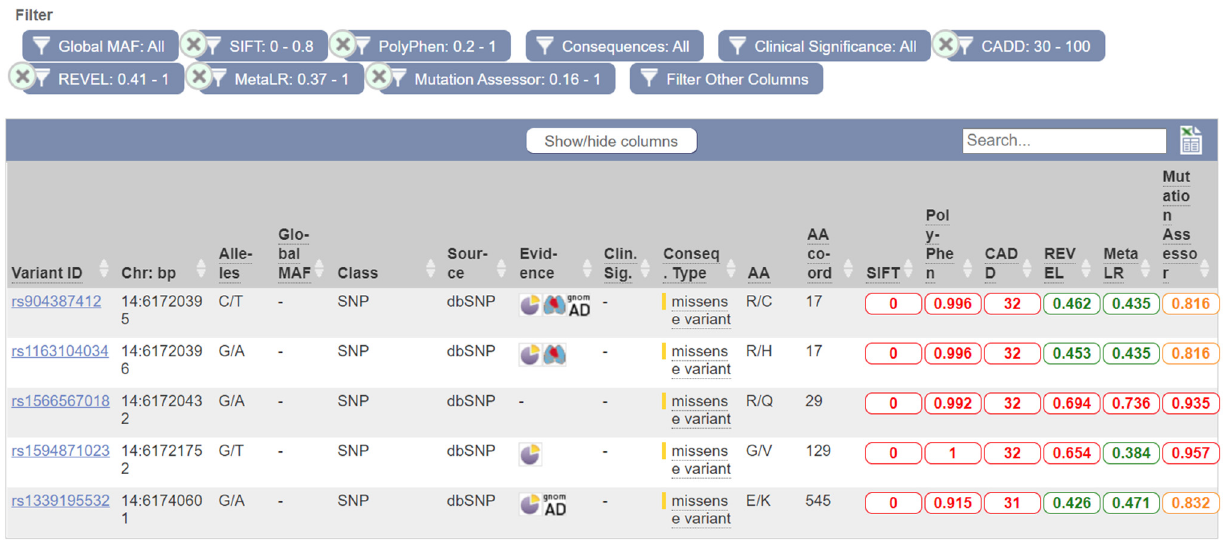
Figure 5. Five HIF1A polymorphisms with predicted effect on protein function. The analysis was performed using six bioinformatics tools included in the Ensembl genome browser.